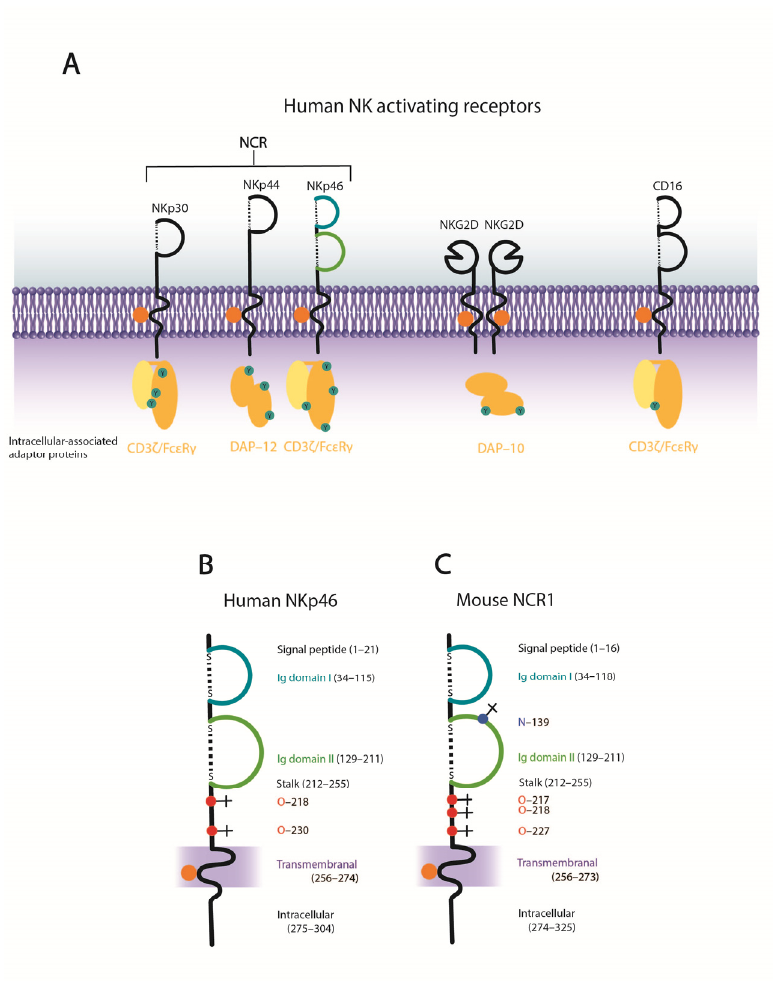
Figure 3. NK cell activating receptors. ( A ) Schematic of human NK cell activating receptors. ( B ) Structural features of hNKp46. In addition to the two predicted O -linked glycosites in the stalk, an additional two O -linked glycosites in the intracellular domain are predicted (NCBI: CAA04714). ( C ) Structural features of murine NCR1 (NCBI: NP_034876). Protein domain predictions were